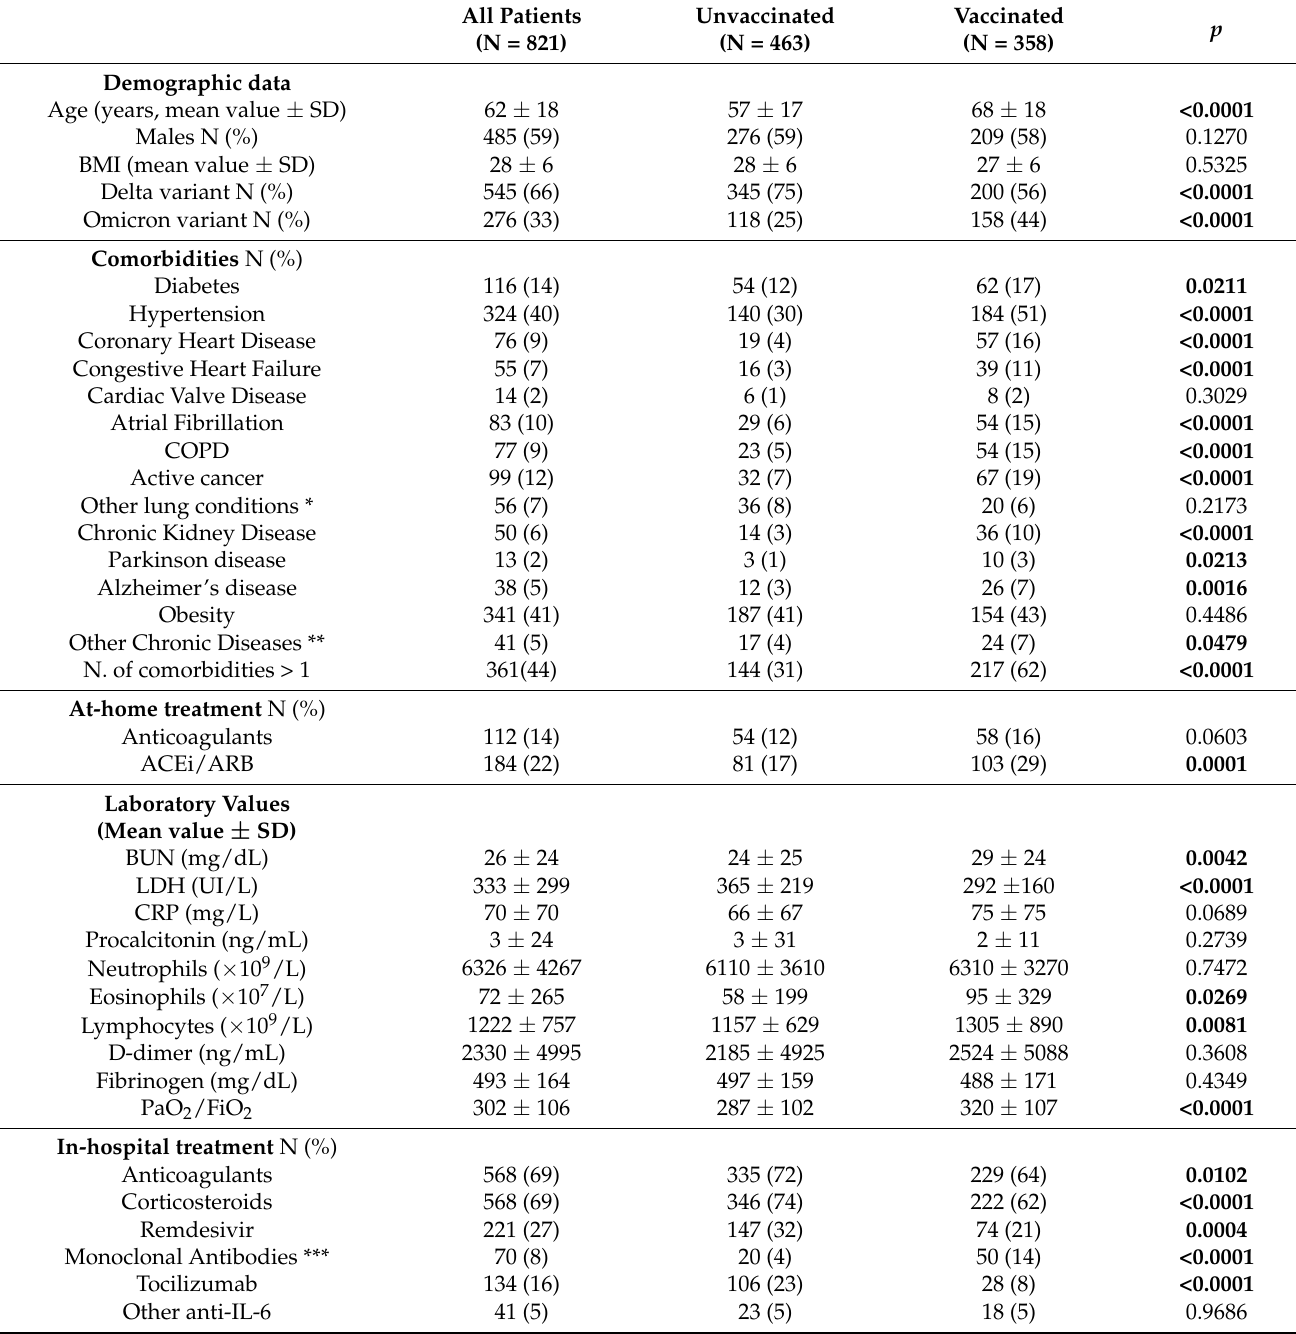
Table 1. COVID-19, patients’ demographic, comorbidities, laboratory, and outcomes data. All